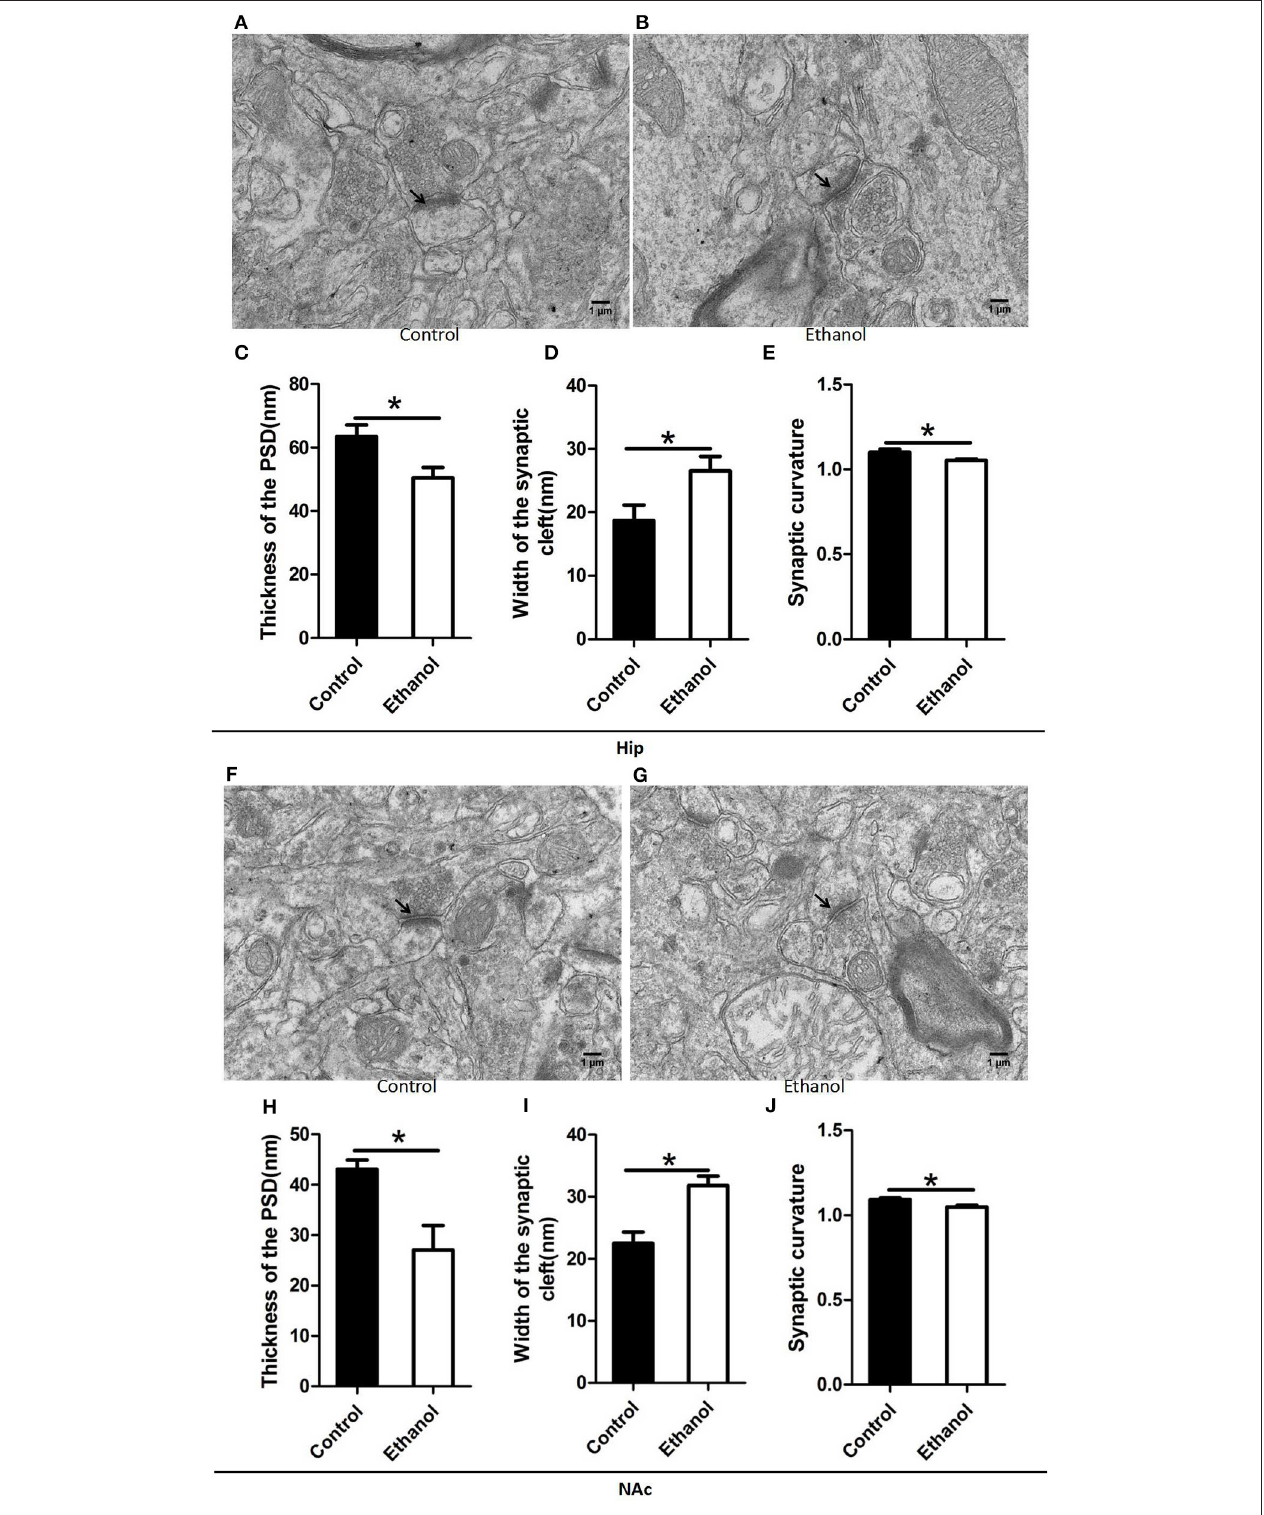
FIGURE 6 | Effects of the ethanol withdrawal procedure on the synaptic ultrastructure in the hippocampus (Hip) and nucleus accumbens (NAc). (C,H) Thickness postsynaptic density (PSD) in the Hip and NAc. (D,I) Width of the synaptic cleft in the Hip and NAc. (E,J) Synaptic curvature in the Hip and NAc. (A,B,F,G) Synaptic ultrastructure in the Hip and NAc under × 12,000 magnification. Data are mean ± standard error. * P < 0.05 was significant.